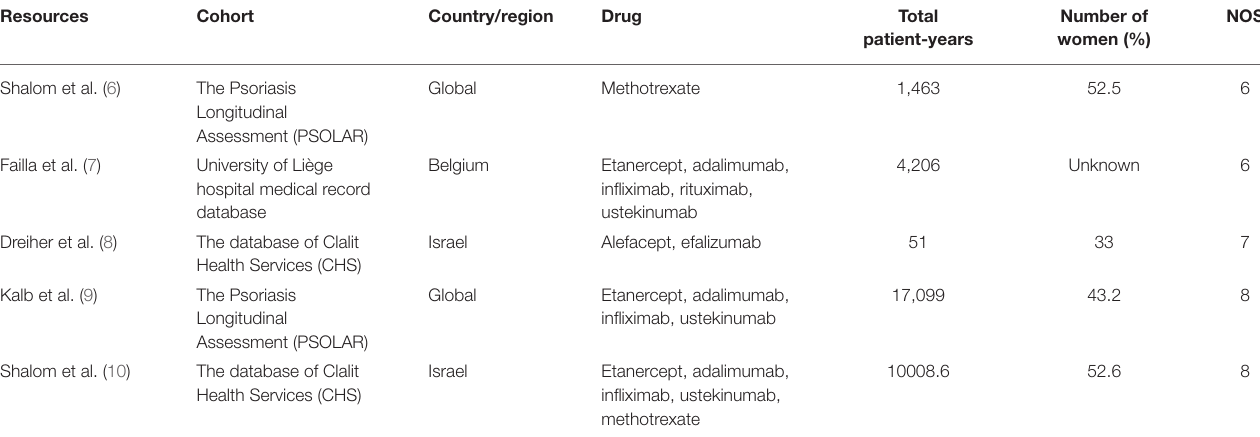
TABLE 1 | Characteristics of the included studies.